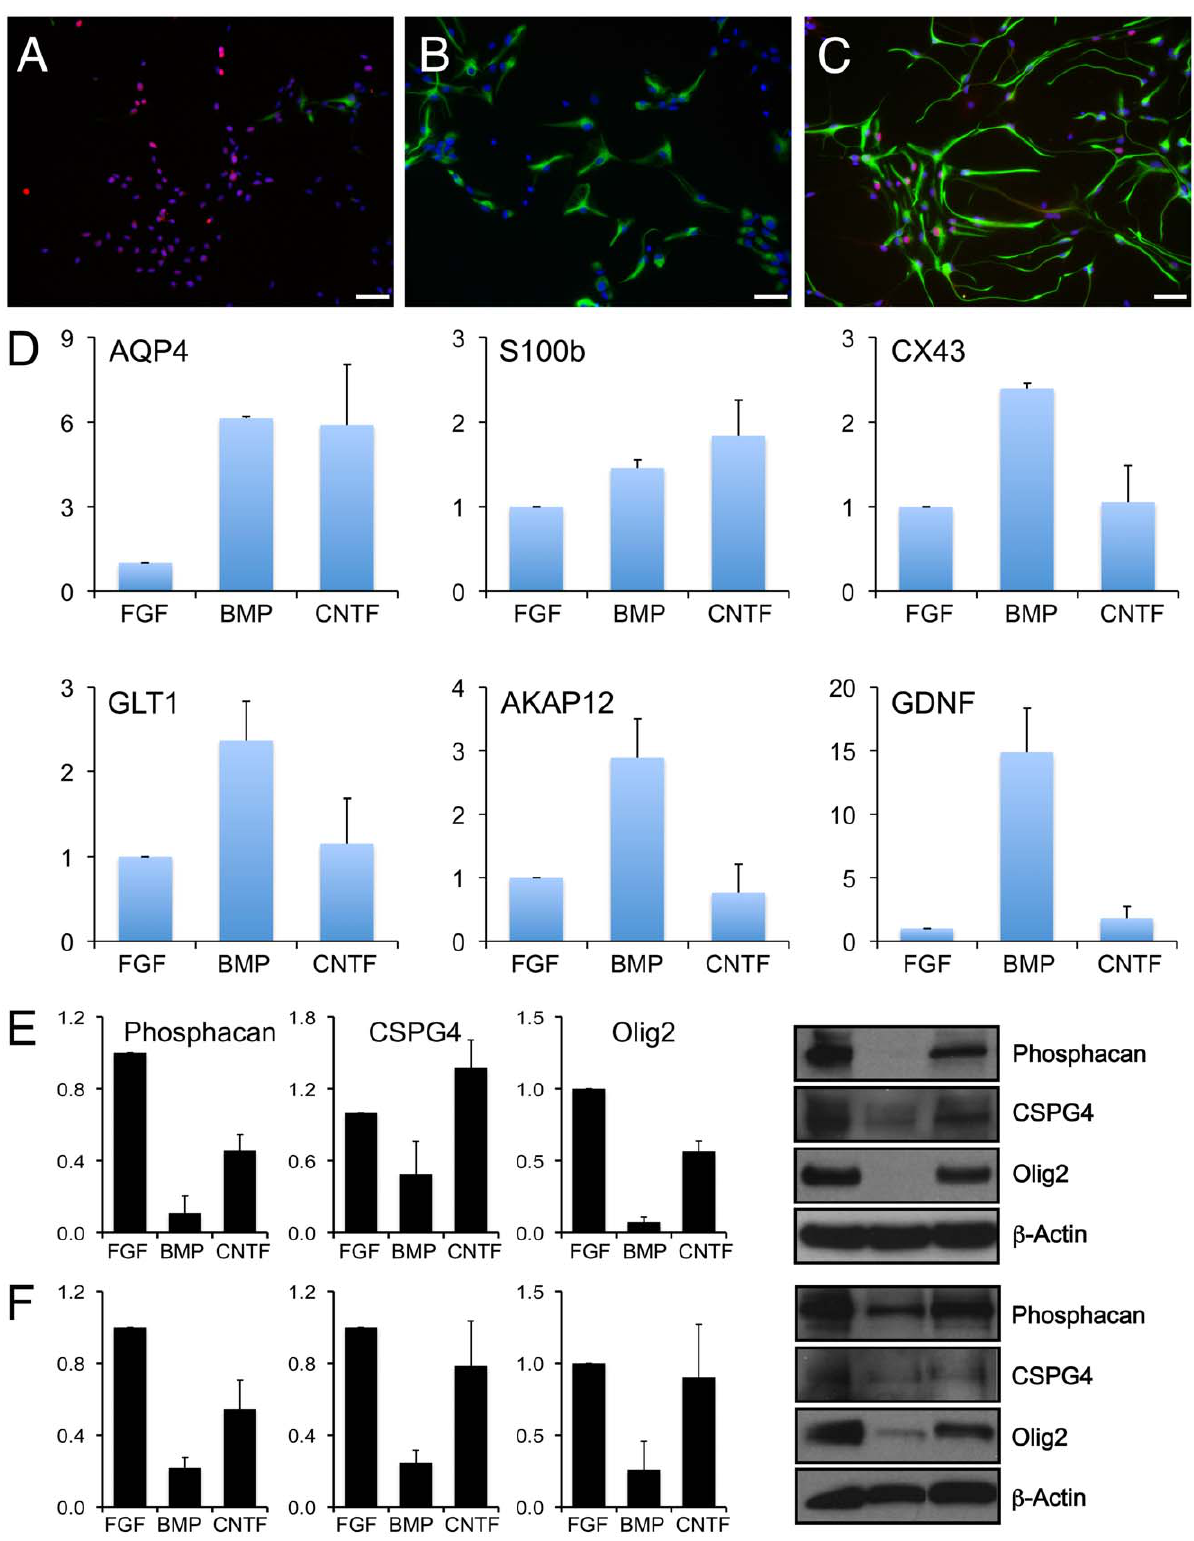
Figure 1. Generation of two distinct types of astrocytes from human glial precursors after treatment with BMP4 or CNTF. Both BMP and CNTF promote the differentiation of hGPCs into GFAP-positive astrocytes expressing S100b but with otherwise distinct morphological and antigenic phenotypes. hGDAs BMP express lower levels of GFAP and exhibit a more compact morphology. hGDAs CNTF have a more elongated morphology and expressed high levels of GFAP. hGDAs CNTF also expressed high levels of neurite-outgrowth inhibitory chondroitin sulfate proteoglycans, phosphacan and CSPG4, as well as the transcription factor Olig2 - all of which have been found to be upregulated in glial scar